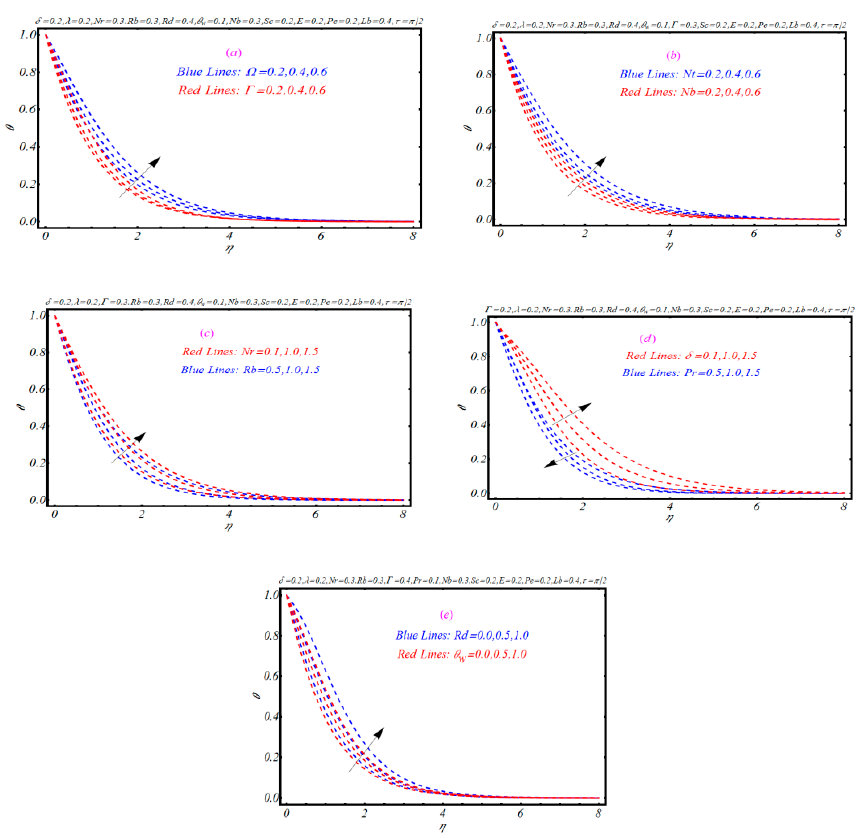
Figure 3. Variation in θ for ( a ) Ω and Γ , ( b ) Nt and Nb , ( c ) Nr and Rb , ( d ) Pr and δ , ( e ) Rd and θ w θ Ω Figure 3. Variation in for ( a ) and